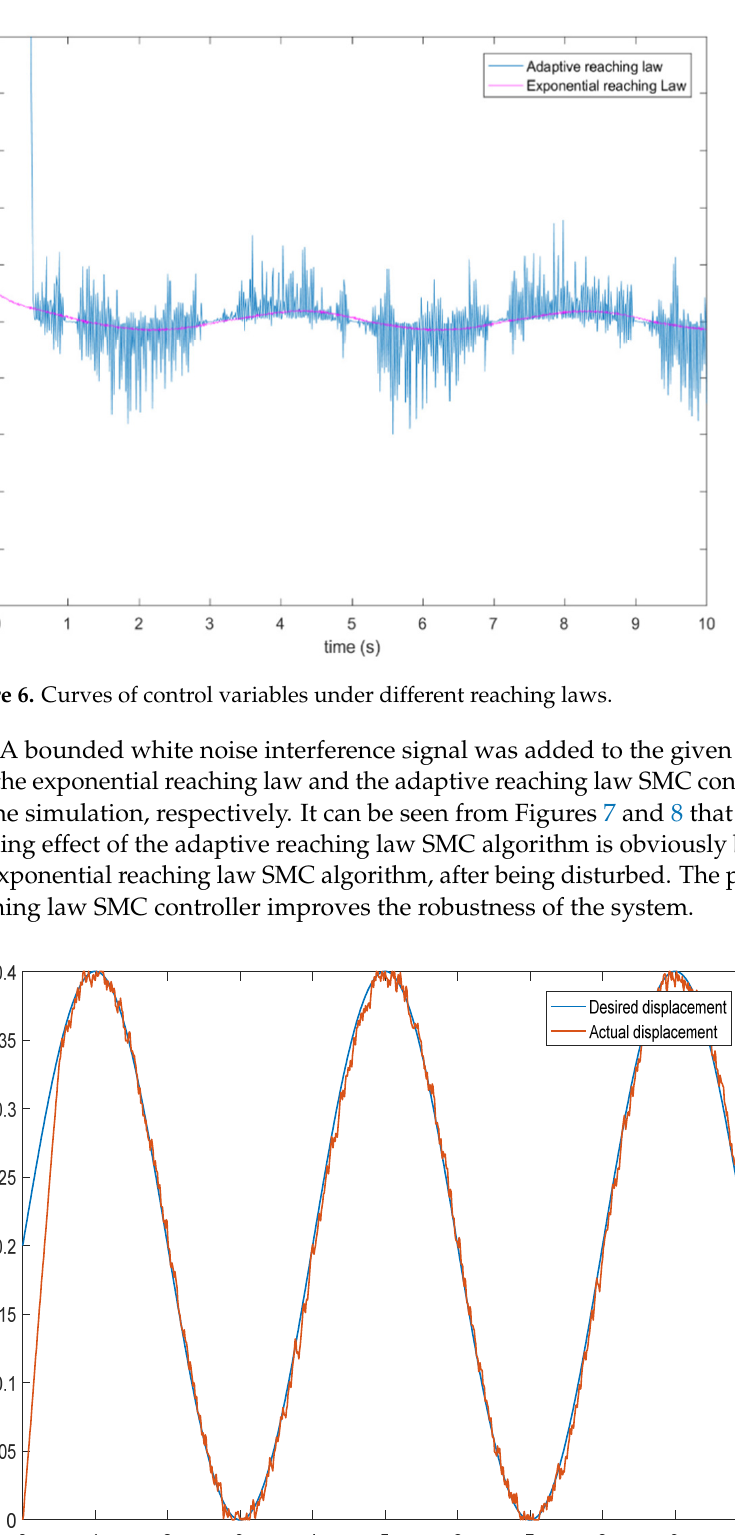
Figure 5. Displacement tracking trajectory of SMC algorithm using adaptive reaching law.